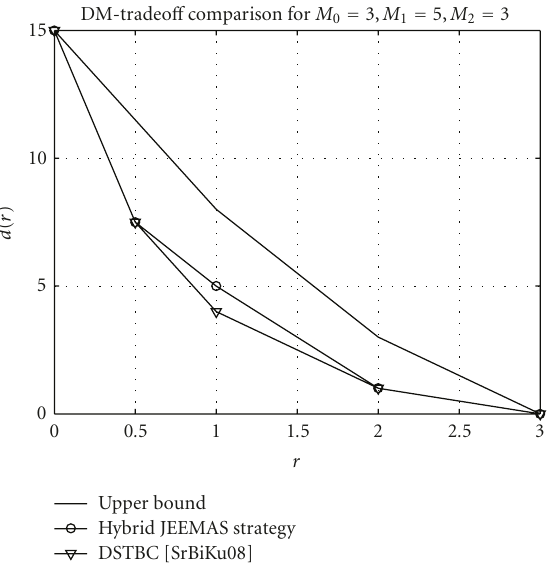
Figure 2: DM-tradeo ff comparison of hybrid JEEMAS with the strategy of [15].